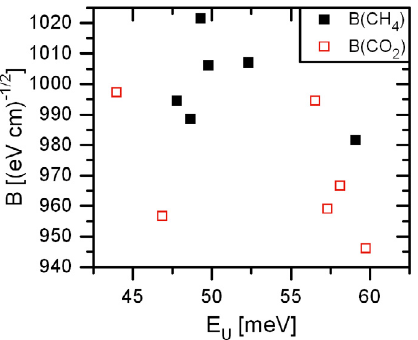
Fig. 5. Hydrogen concentration deduced from Si-H stretching modes around the wavenumber ν = 2000 cm − 1 for amorphous silicon alloy single layers produced with CO 2 or CH 4 on c-Si wafers.